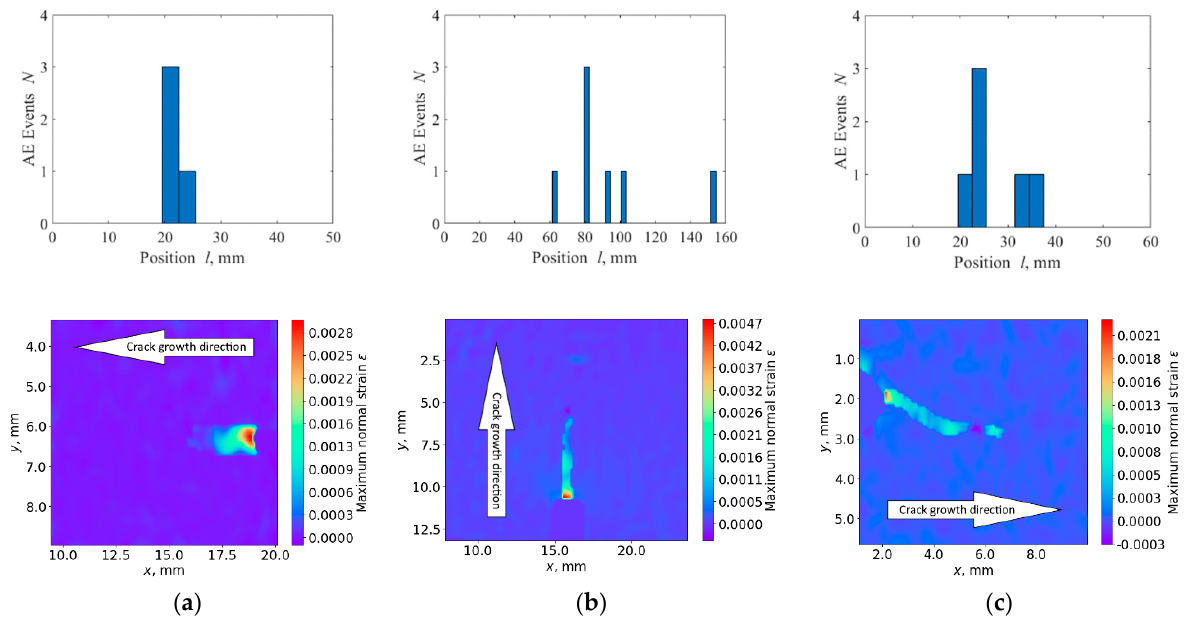
Figure 4. AE ( N ( l ), upper row) and DIC ( ε ( x , y ), lower row) data for rail ( a ), wheelset ( b ), and traction clamp ( c ) samples at the moments T AE and T DIC , respectively.